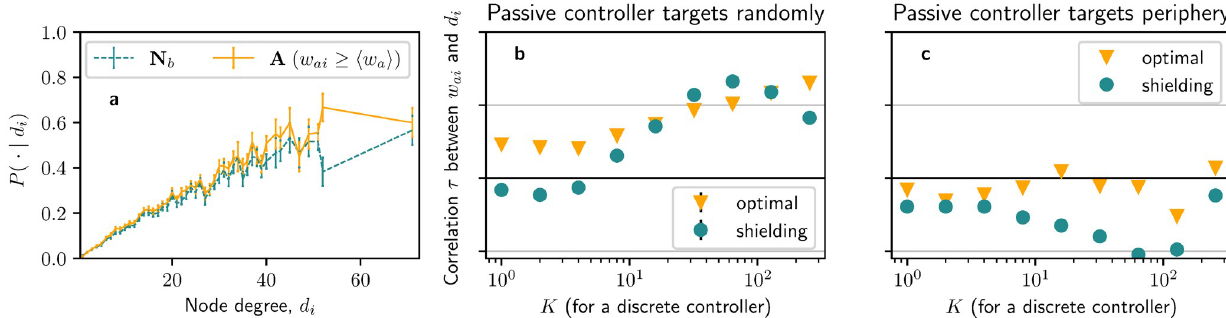
Fig 5. Correlations between optimal influence allocations and node degree. a Probability of optimal allocations belonging to A given node degree d i ( solid ) and probability of nodes belonging to N given node degree d ( dashed ), with a passive controller targeting K = 16 random nodes in a discrete b i fashion. b, c Kendall rank correlation coefficients τ between allocation strength w ai and node degree d i for different K when the active controller targets nodes optimally ( squares ) or following a shielding strategy ( circles ). In a and b the passive controller targets random nodes in the network. In c , the passive controller targets the nodes whose neighbours have the lowest possible degree. Error bars represent standard errors over a 60 or b 15 instances of the experiments. Correlations in c correspond to a single instance of the experiment, as the strategy of the passive controller is deterministic. The total budget of both controllers sums up to B þ B ¼ N h d i = 30 a b